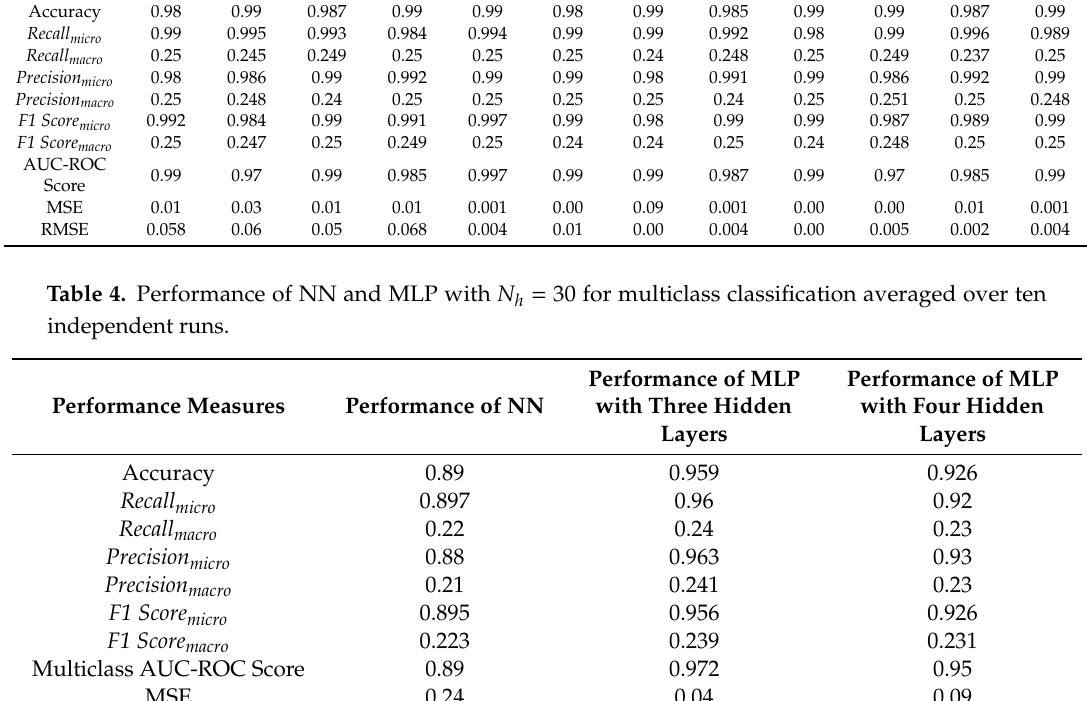
Table 3. Performance of NN and MLP with N h = 80 for each class averaged over ten independent runs. Performance Performance of NN Measures Accuracy